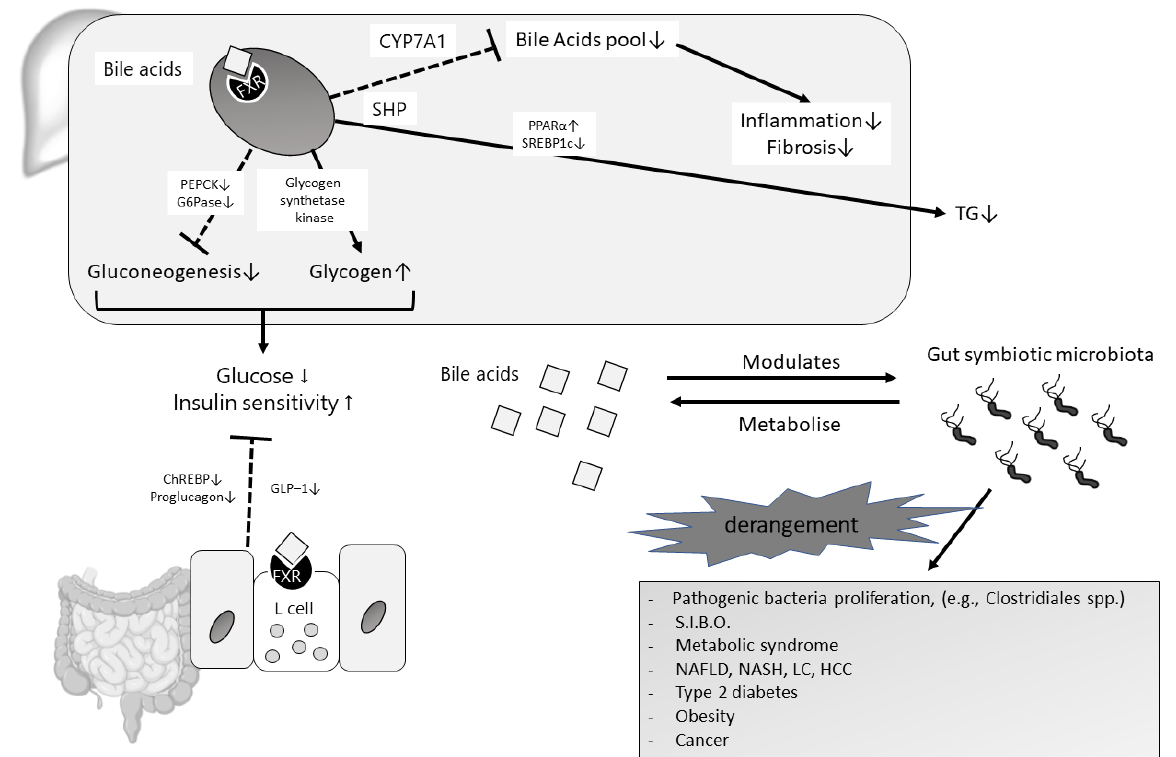
Figure 2. The gut–liver axis representation with special focus on BAs and gut microbiota relationship in healthy and pathologic conditions.